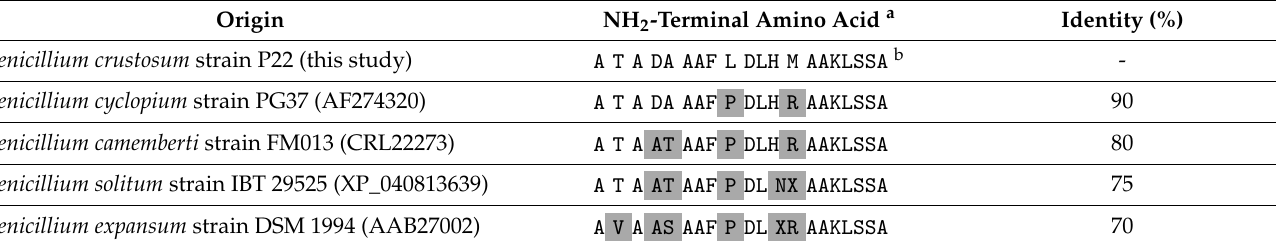
a Residues not identical with the PCrL are shaded. The GenBank accession number is in parentheses. b Amino acid sequences for comparison were obtained using the program BLASTP (NCBI, NIH, USA) database. X: any amino